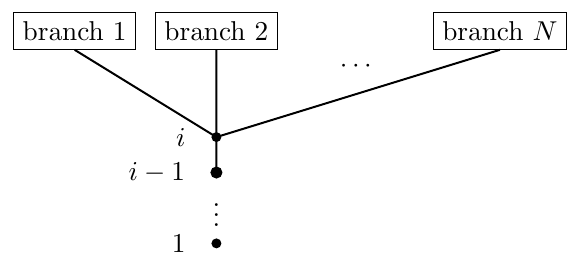
Figure 2 . A tree whose first level contains N